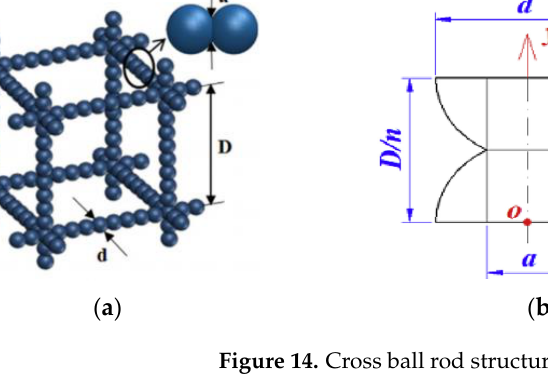
Figure 14. Cross ball rod structure: ( a ) Cross ball rod structure; ( b ) Structure diagram of q s and q sg ; ( c ) Structure diagram of q sgs .